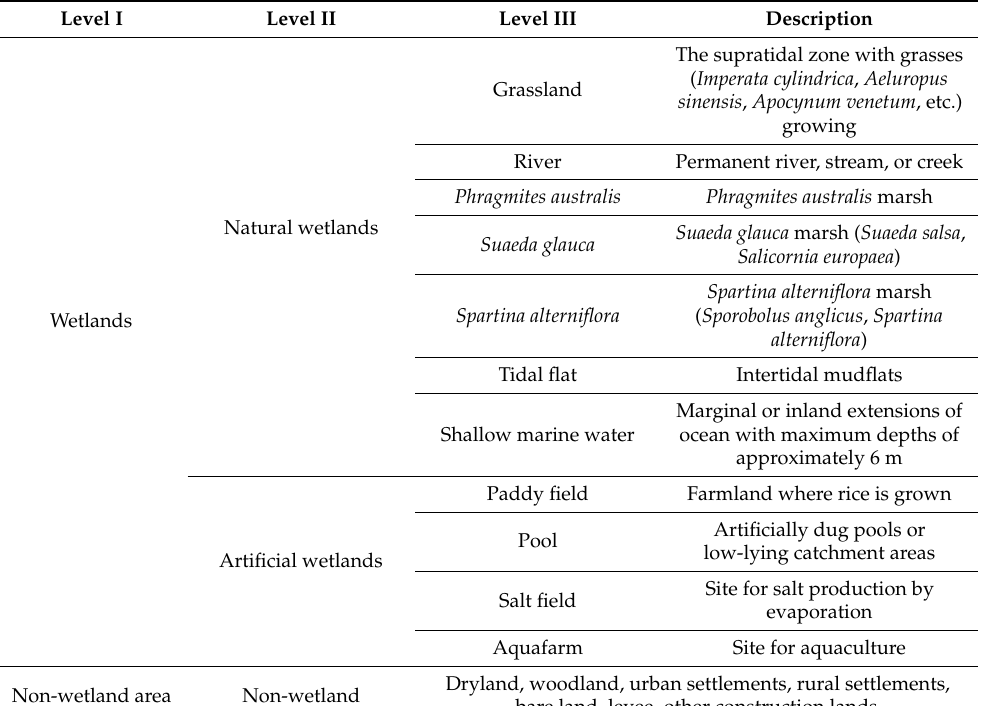
Table 2. Landscape classification